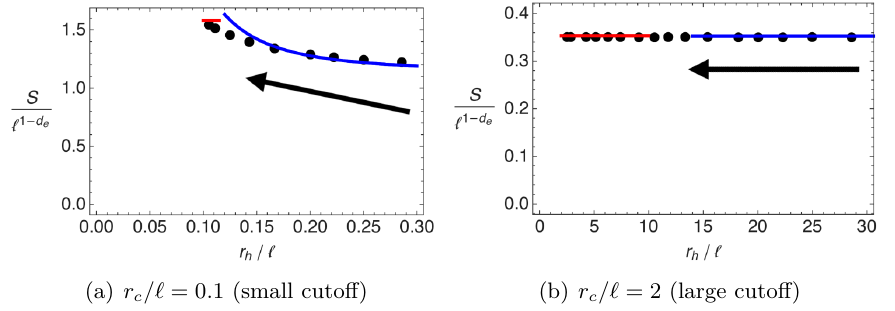
Figure 3 . S/‘ 1 − d e vs. r h /‘ at ( d e , z ) = (1 / 2 , 2) . Dots are numerical results interpolating the analytic results between eq. (2.19) (red; r ) and eq. (2.11) (blue; r h → r c eq. (2.17) (blue; r ; right panel). In all figures, the arrow indicates the direction of increasing h → ∞